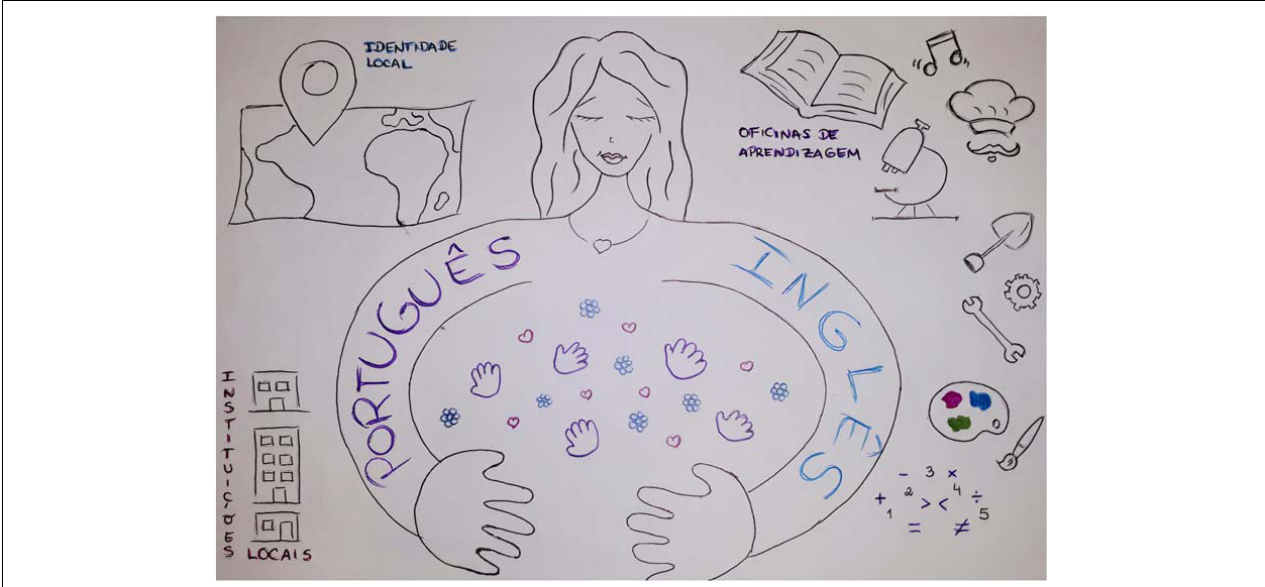
FIGURE 3 | “Me as a GCE teacher”: Chloe’s